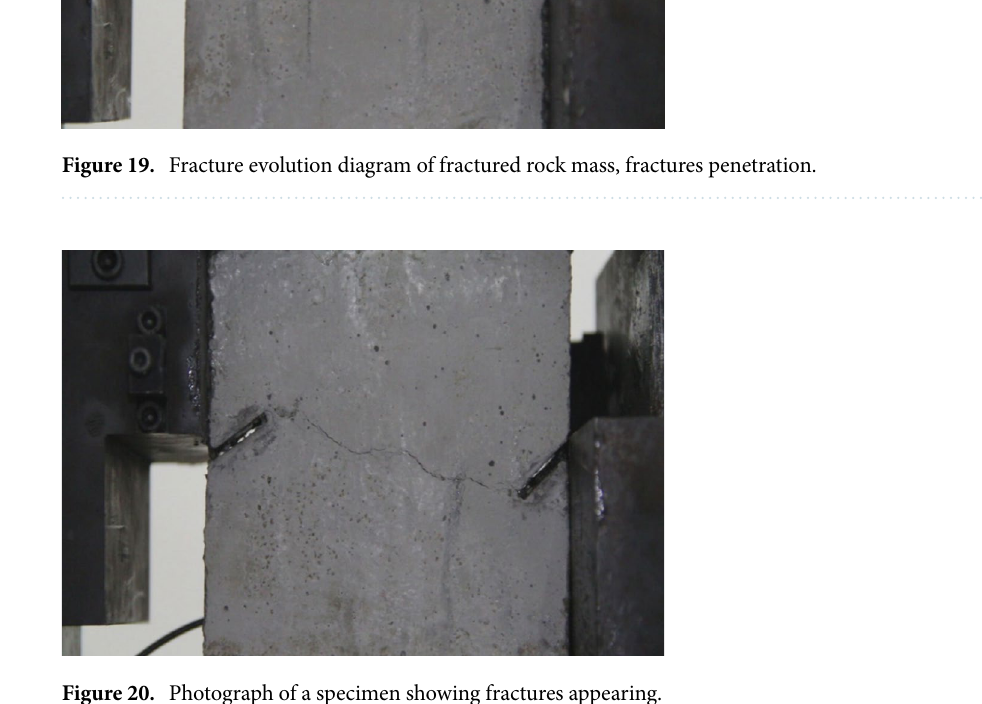
Figure 20. Photograph of a specimen showing fractures